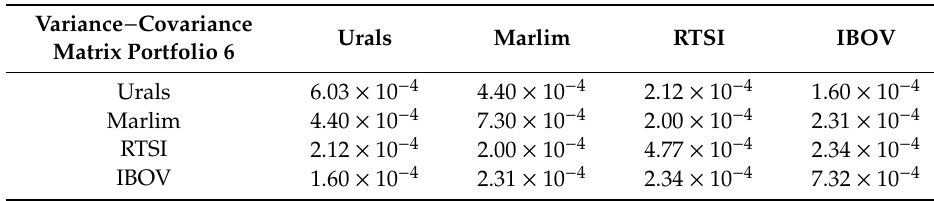
Table A30. Maximum Likelihood Variance–Covariance Matrices for portfolio 6: Urals, Marlim, RTSI, IBOV. Elaborated by authors with data from